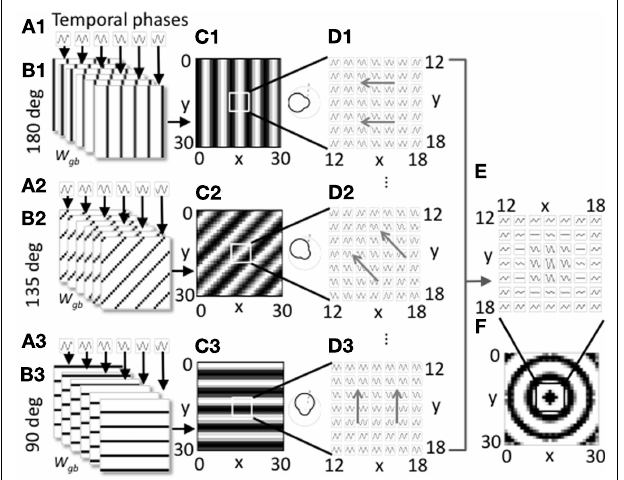
FIGURE 1 | Overview of model components for a single spatial phase. (A1–A3) .Three groups of heading angle cells described by Eq. 1 show oscillations over time with different temporal phases (six phases shown). (B1–B3) The three groups project to grid cells with synaptic connectivity that depends on the six different temporal phases and the heading angles of 180˚ (B1) , 135˚ (B2) , and 90˚ (B3) . Only 3 of 24 heading angles are shown. Connectivity also depends upon spatial phase.The groups shown all code a single spatial phase. (C1–C3) At a single time t , the synaptic input to the grid cell population from a full set of temporal phases coding an individual heading angle and spatial phase contains bands of higher amplitude (black).The polar plots on the right show how the output amplitude for each heading angle will change dependent on the direction of movement. (D1–D3) The full time course plotted for a 7 by 7 array of synaptic inputs shows that they oscillate over time with different temporal phases and align to form different spatial bands. Different spatial phases reach the peak of the oscillation at different times resulting in a shift in the bands over time in the direction of the gray arrows. (E) Synaptic input to a 7 by 7 array of grid cells is shown summed across all heading angles for a group of cells coding the spatial phase in the center of the grid cell plane ( x = 15, y = 15). (F) At a single point in time, for this single spatial phase, the distribution of synaptic input to the full 30 by 30 array of the grid cell plane when summed over all heading angles has a circularly symmetric pattern.